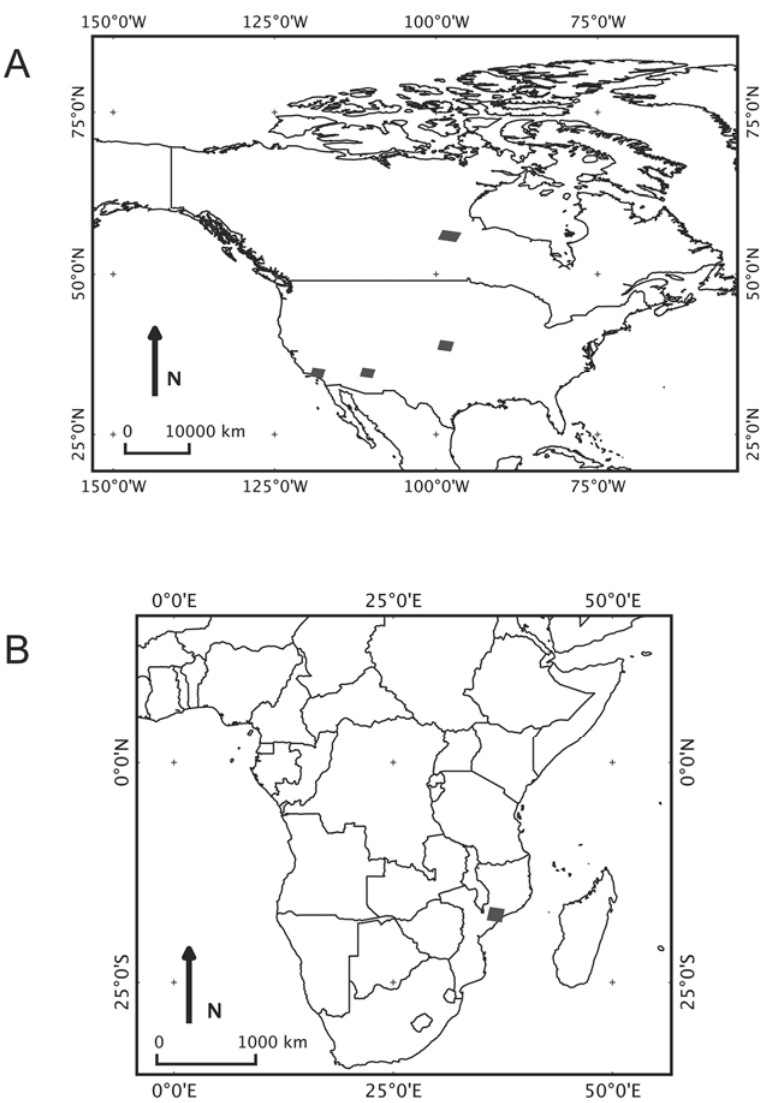
Figure 1. Location of study sites in North America ( A ) and in Africa ( B ). Grey polygons indicate the swath of the Landsat